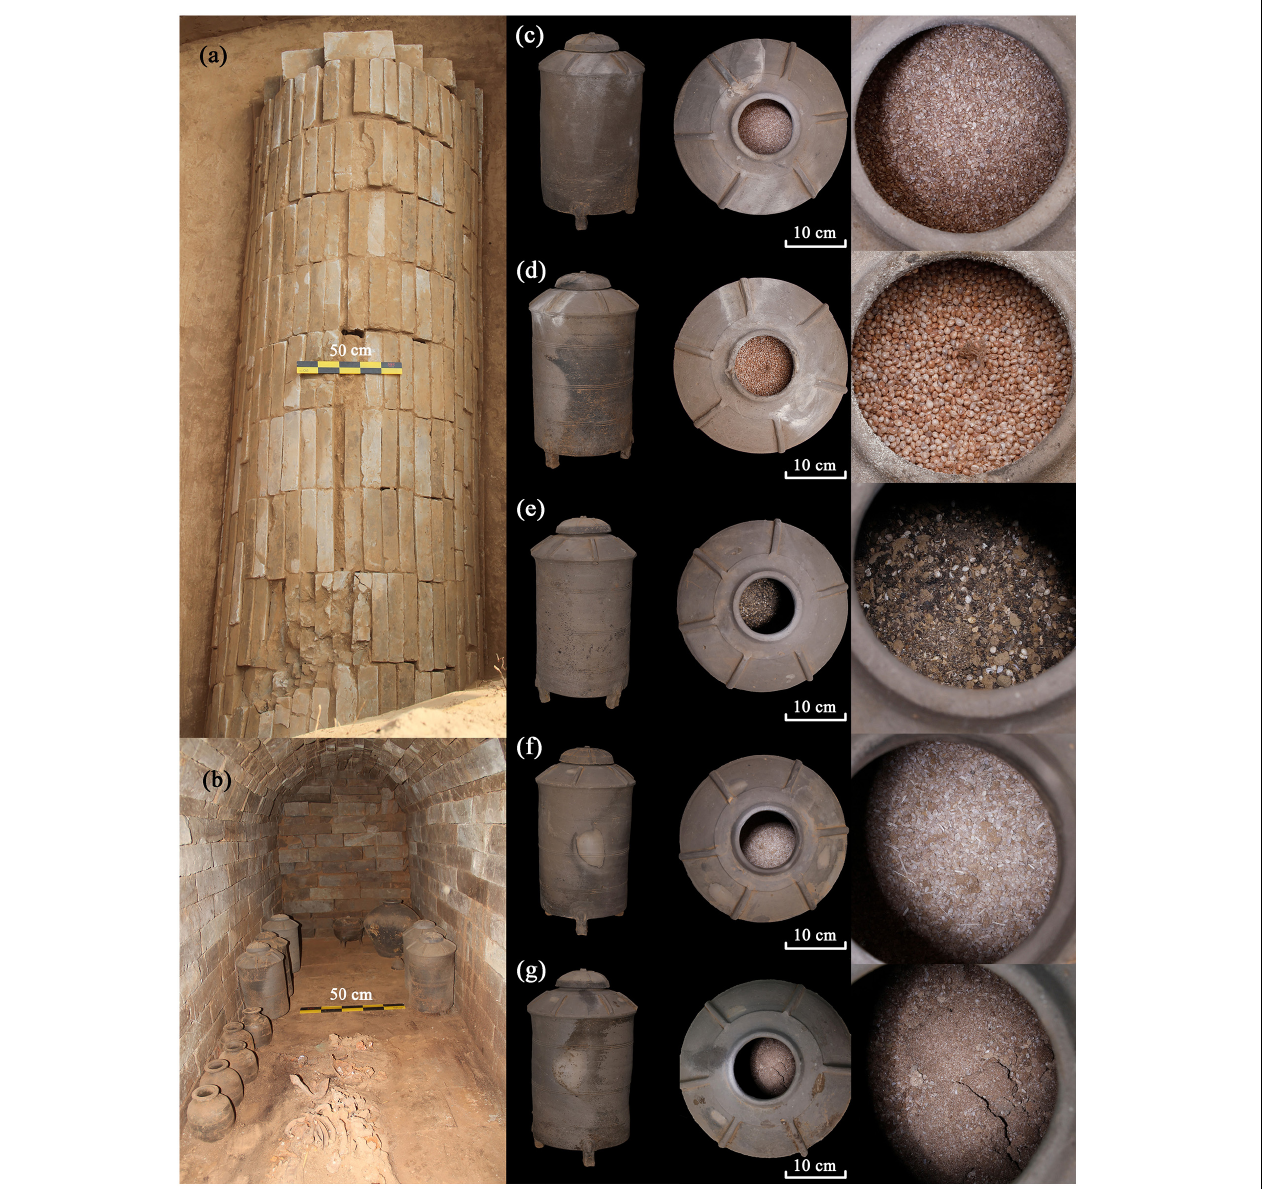
FIGURE 2 | M111 tomb at the Longzaocun cemetery, (a) overhead photograph of the tomb; (b) interior photograph of M111 and buried objects, (c–g) photographs of pottery model granary and plant remains.